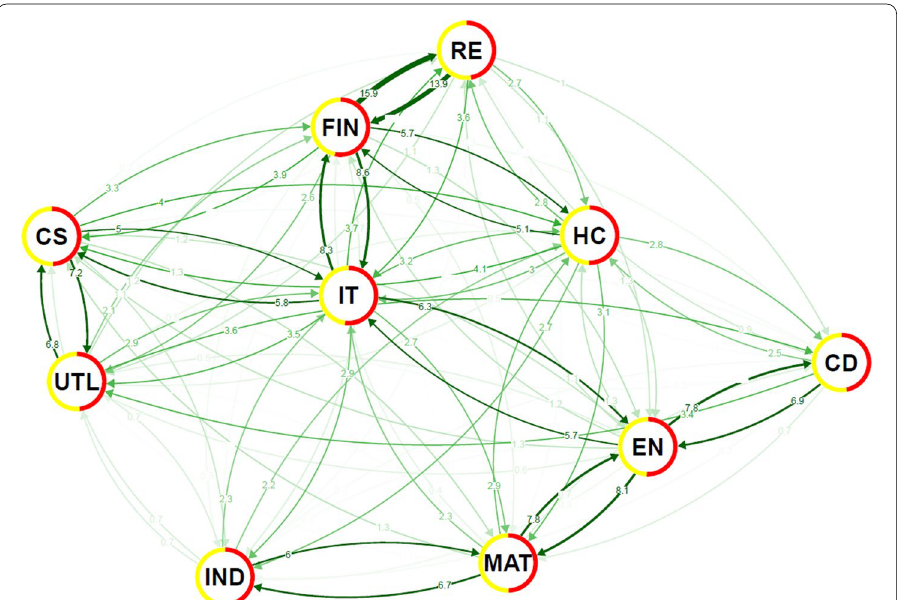
Fig. 3 DY spillover based on conditional mean: ordinary least squares (OLS) estimator. Note: This network graph shows the degree of connectedness among the US sectors over the full sample period. The pair-wise connectedness is measured using the Diebold-Yilmaz framework. The thickness of an edge is proportional to its weight and spillover is shown as a numeric value on the start of an edge. Edges are drawn as curves and the direction of pairwise spillovers is shown through arrows. The net spillover for a node (US stock sector) is shown as pie around border where red is for transmission and yellow for reception. A higher percentage of red indicates that the node is a net spillover transmitter. The layout of the nodes is determined by applying the force-directed algorithm of Fruchterman and Reingold (1991)